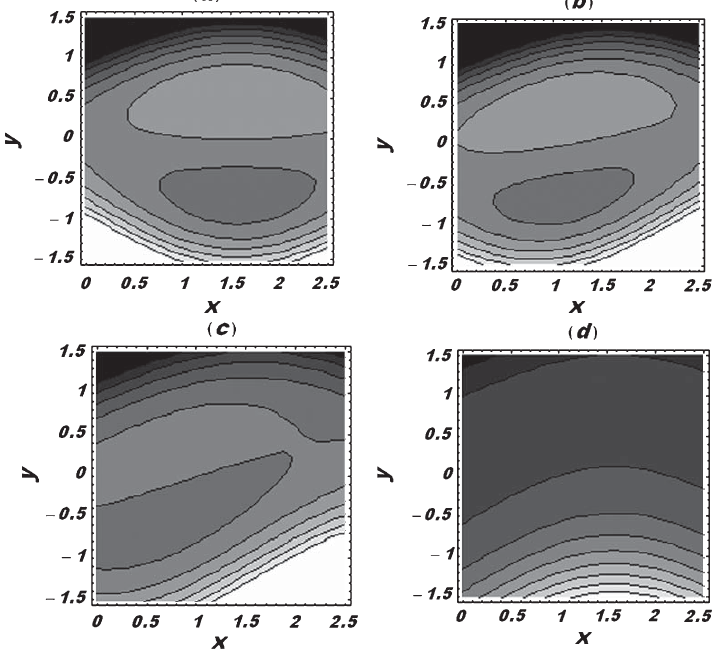
Fig. 20. Streamlines for a = 0 . 4, b = 0 . 4, d = 1, Re = 10, Fr = 1, φ = π/ 6, β = 0 . 01, sin α = 0 . 2, dp (2) /dx = 1, θ = 1 . 4 with different (cid:15) (a) (cid:15) = 0 . 00, (b) (cid:15) = 0 . 1, (c) (cid:15) = 0 . 2, (d) (cid:15) = 0 . 3.